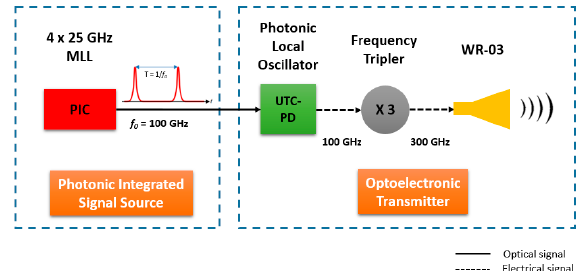
Figure 1. Block diagram of the 300 GHz optoelectronic transmitter based on UTC-PD and Schottky tripler diode technology, fed by a photonic integrated signal source. MLL: Mode-locked laser; PIC: Photonic integrated circuit; UTC-PD: Uni-travelling carrier photodiode; WR-03: Rectangular waveguide 03.